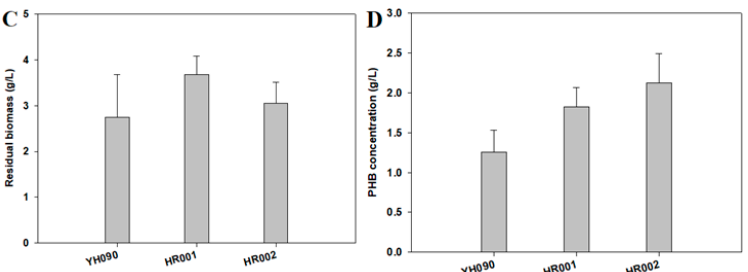
Figure 2. Polyhydroxybutyrate (PHB) production in engineered E. coli : ( A ) DCW (dry cell weight, g/L); ( B ) PHB content (wt/wt %); ( C ) residual biomass (g/L); and ( D ) PHB concentration (g/L). Cell cultivation was conducted for 48 h in M9 minimal medium containing 2% glucose as a sole carbon source. Error bars represent the standard deviations of two replicates.